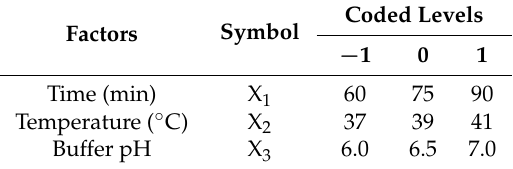
Table 4. Factors and levels of the experimental design for CEP extraction conditions.